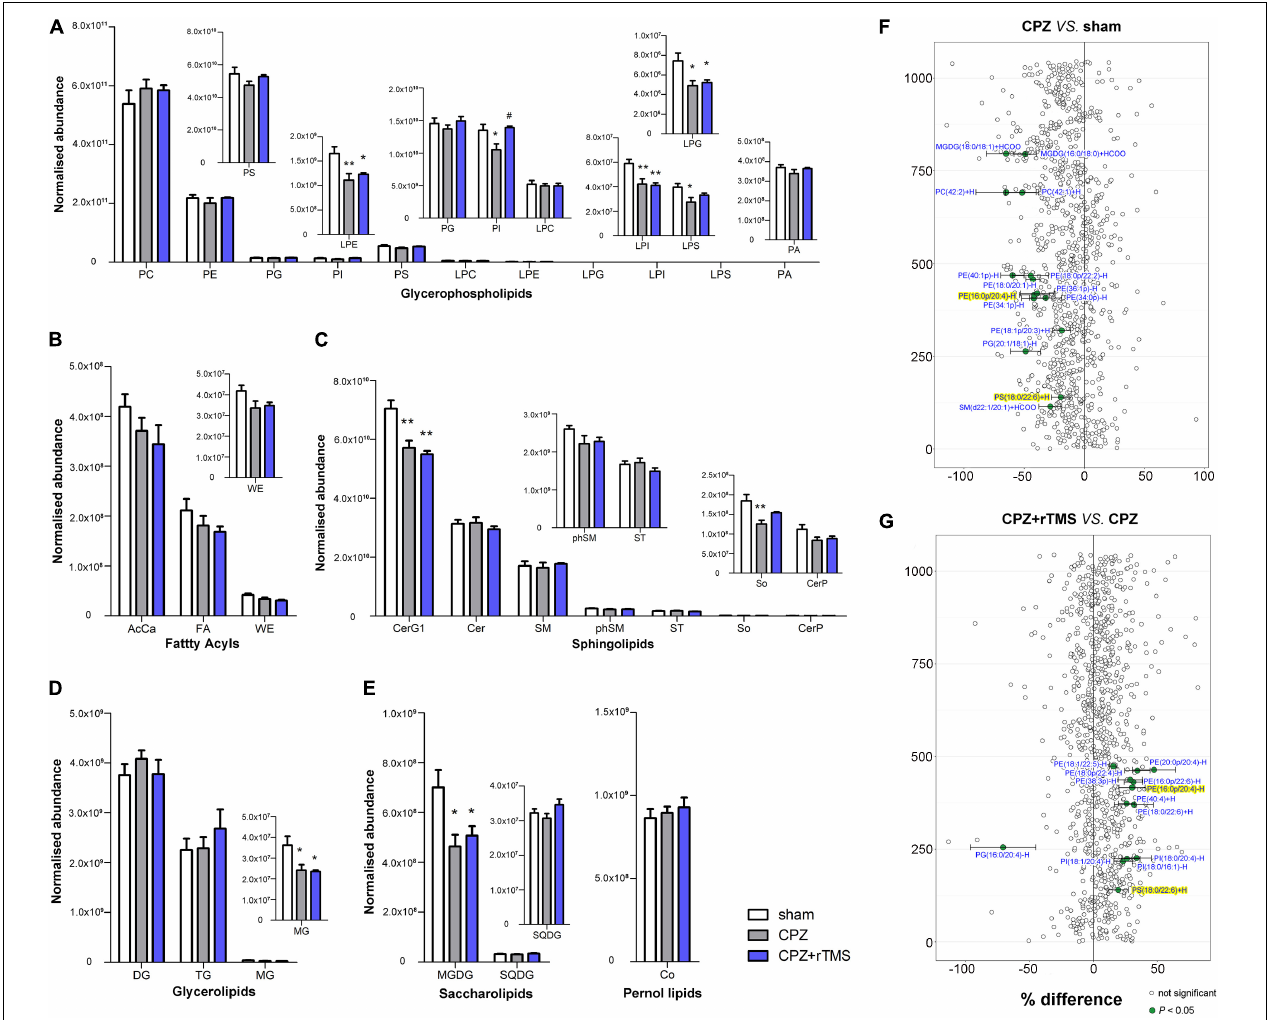
FIGURE 5 | Alterations in lipidomic profiles and the characterization of lipids in the striatum of mice in each group. Six main lipid classes were analyzed: (A) glycerophospholipids, (B) fatty acyls, (C) sphingolipids, (D) glycerolipids, (E) saccharolipids, and pernol lipids. Lipids showing low levels results have been enlarged in insets. (F,G) Forest plots of individual lipids in the striatum of mice in the CPZ group expressed as a percent difference compared to shams, CPZ + rTMS group expressed as a percent difference compared to the CPZ group. Molecules indicated in green represent significant differences in individual lipids ( P < 0.05). Lipids highlighted in yellow indicate lipids that were modulated in a contrary direction compared to the CPZ group. PC, phosphatidylcholine; PE, phosphatidylethanolamine; PG, phosphatidylglycerol; PI, phosphatidylinositol; PS, phosphatidylserine; LPC, lysophosphatidylcholine; LPE, lysophosphatidylethanolamine; LPG, lysophosphatidylglycerol; LPI, lysophosphatidylinositol; LPS, lysophosphatidylserine; PA, phosphatidic acid; AcCa, acylcarnitine; FA, fatty acid; WE, wax esters; Cer, ceramides; CerG, glucosylceramides; SM, sphingomyelin; phSM, sphingomyelin (phytosphingosine); ST, sulfatides; So, sphingosine; CerP, ceramide phosphates; DG, diglyceride; TG, triglyceride; MG, monoglyceride; MGDG, monogalactosyldiacylglycerol; SQDG, sulfoquinovosyl diacylglycerol; Co, coenzyme. * P < 0.05 vs. sham; ** P < 0.01 vs. sham; # P < 0.05 vs.